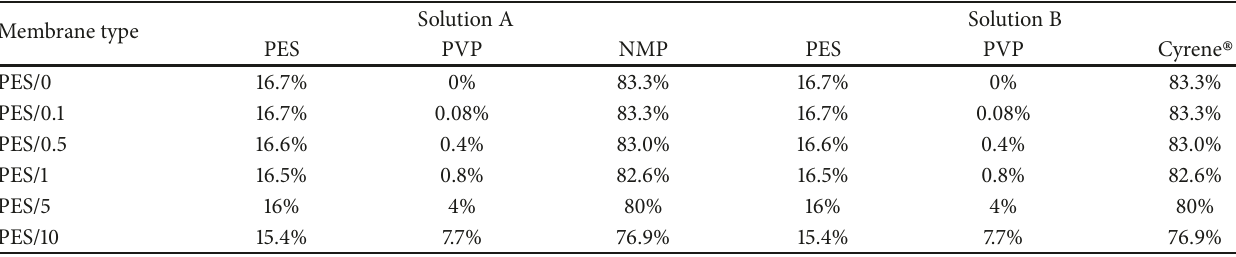
Table 2: Composition of casting solutions (g).